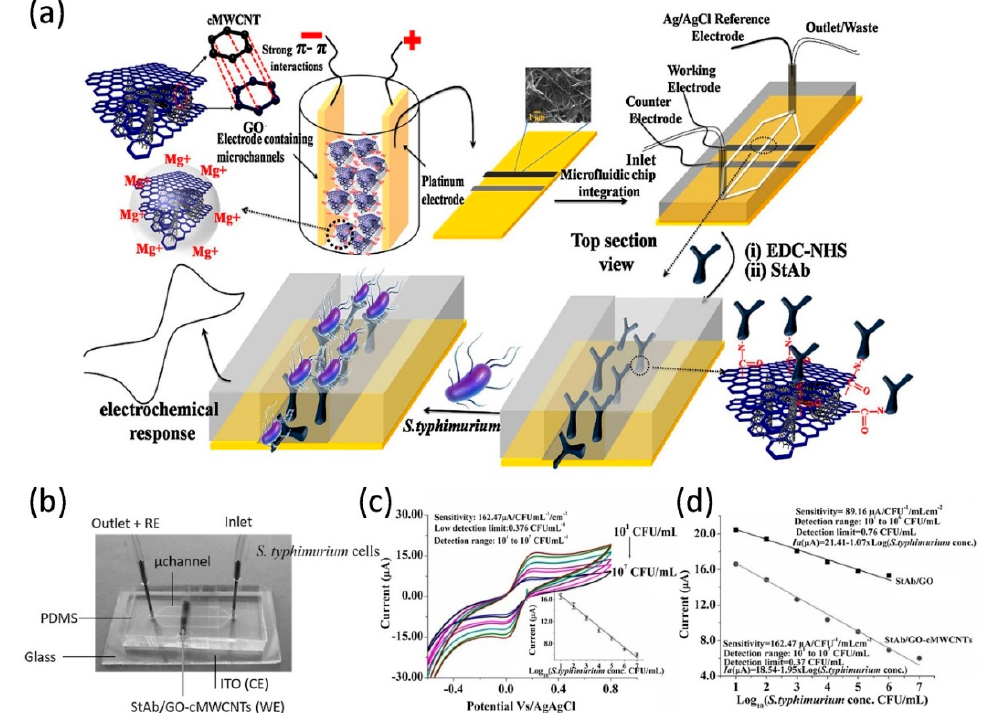
Figure 9. ( a ) Schematic for the fabrication of GO wrapped multiwalled carbon nanotubes integrated microfluidic chip. ( b ) Real image of the StAb / GO-cMWCNTs based microfluidic immunochip. ( c ) Electrochemical response of StAb / GO-cMWCNTs microfluidic electrodes to pathogenic cells. ( d ) Comparative electrochemical response curves of GO and GO / cMWCNTs based electrodes for Salmonella typhimurium detection. Reproduced from [103] with the permission from ELSEVIER.